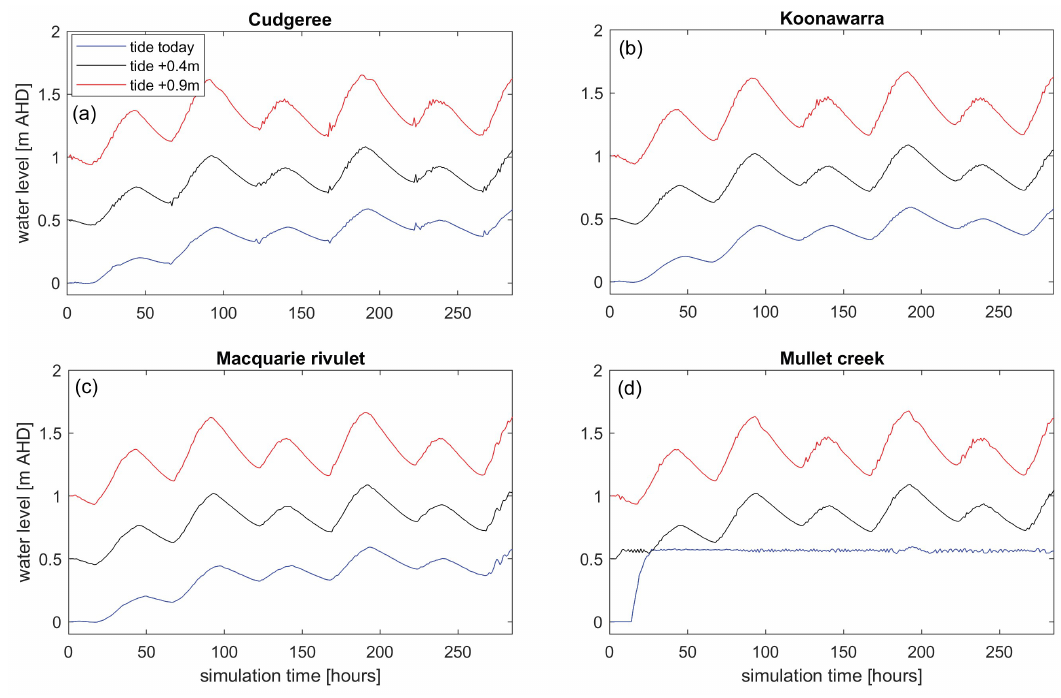
Figure 4. Simulated water levels for spring-tidal conditions and SLR scenarios over 6 tidal cycles at Cudgeree ( a ), Koonawarra ( b ), Macquarie Rivulet ( c ), and Mullet Creek ( d ) in Lake Illawarra. Mullet Creek monitoring point is not subject to tides at present sea level conditions due to its upstream location behind a tidal weir.